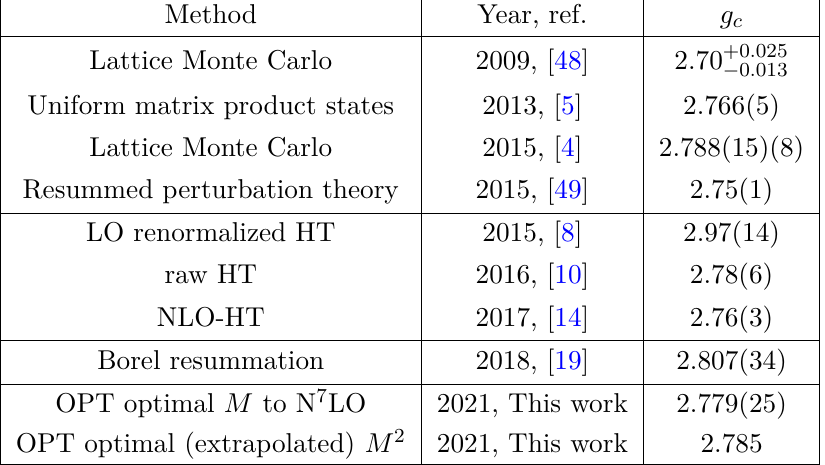
Table 4 . Summary of recent